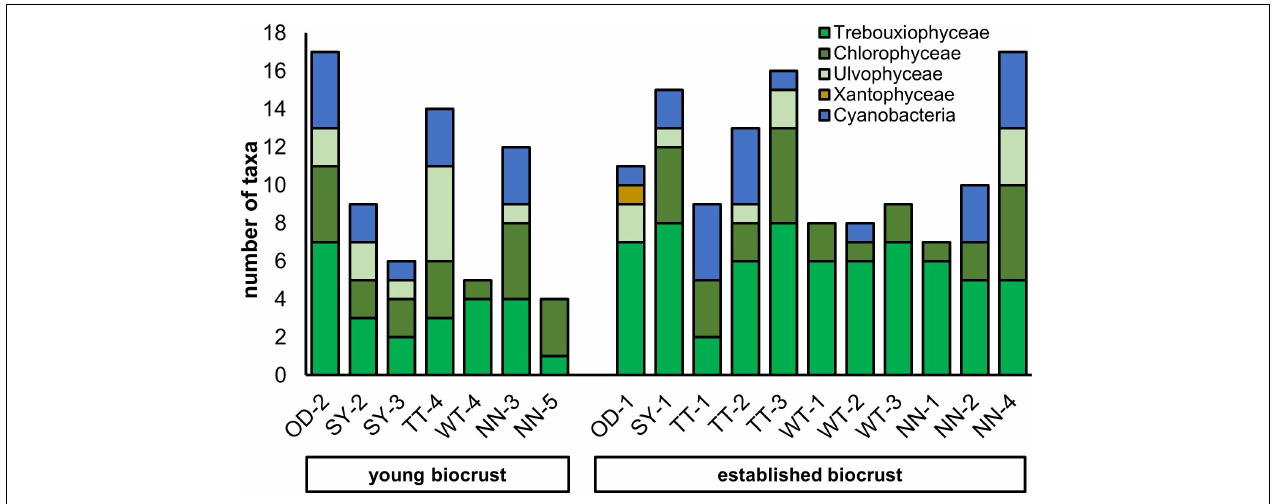
FIGURE 6 | Number of taxa isolated from biocrust samples (OD, Oedesse; SY, Shreyahn; TT, Teutschenthal; WT, Wietze; NN, not further described) grouped by biocrust type divided in algae classes and cyanobacteria.